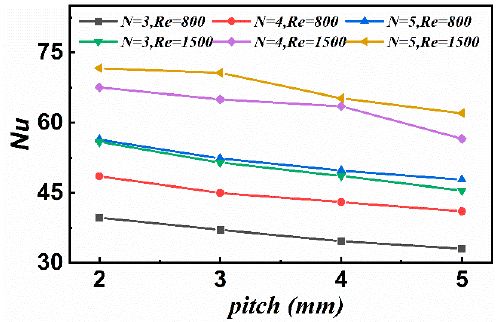
Figure 12. Variations of 𝑵𝒖 with deflector pitch at A = 30°.